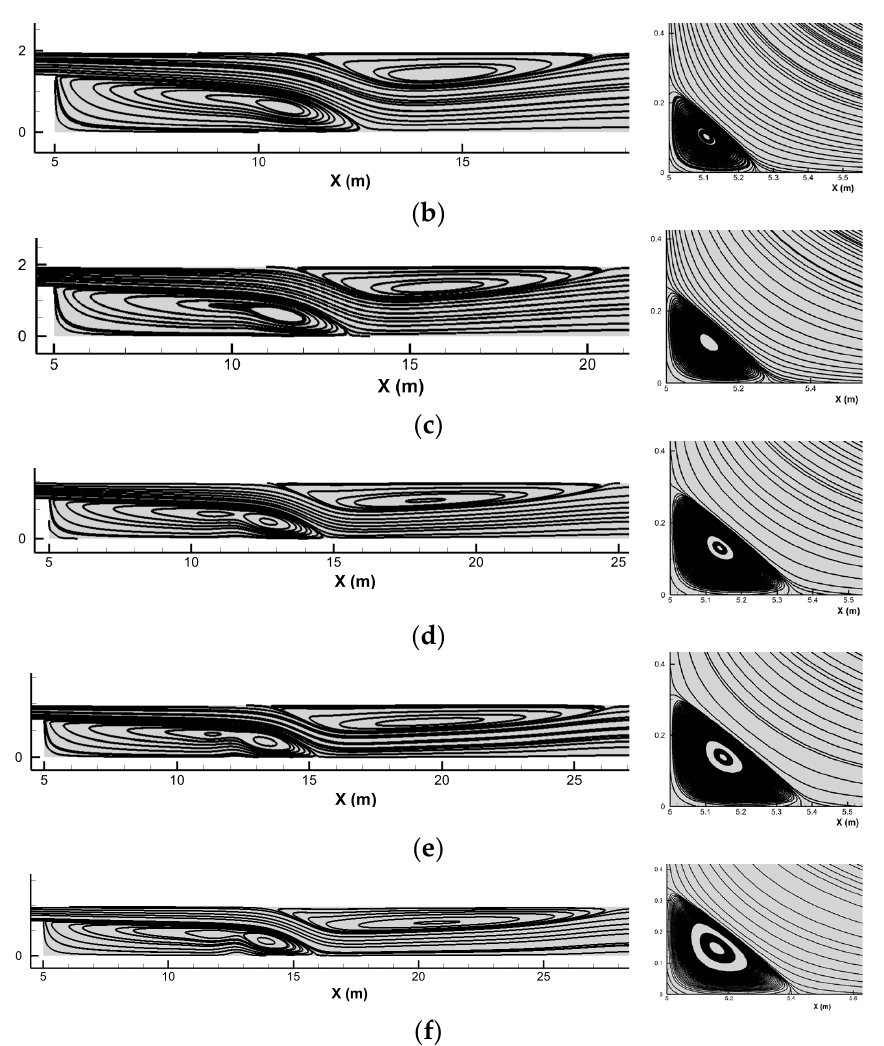
Figure 7. Streamlines various Reynolds numbers; ( a ) 200, ( b ) 250, ( c ) 300, ( d ) 400, ( e ) 450, and ( f ) 500.